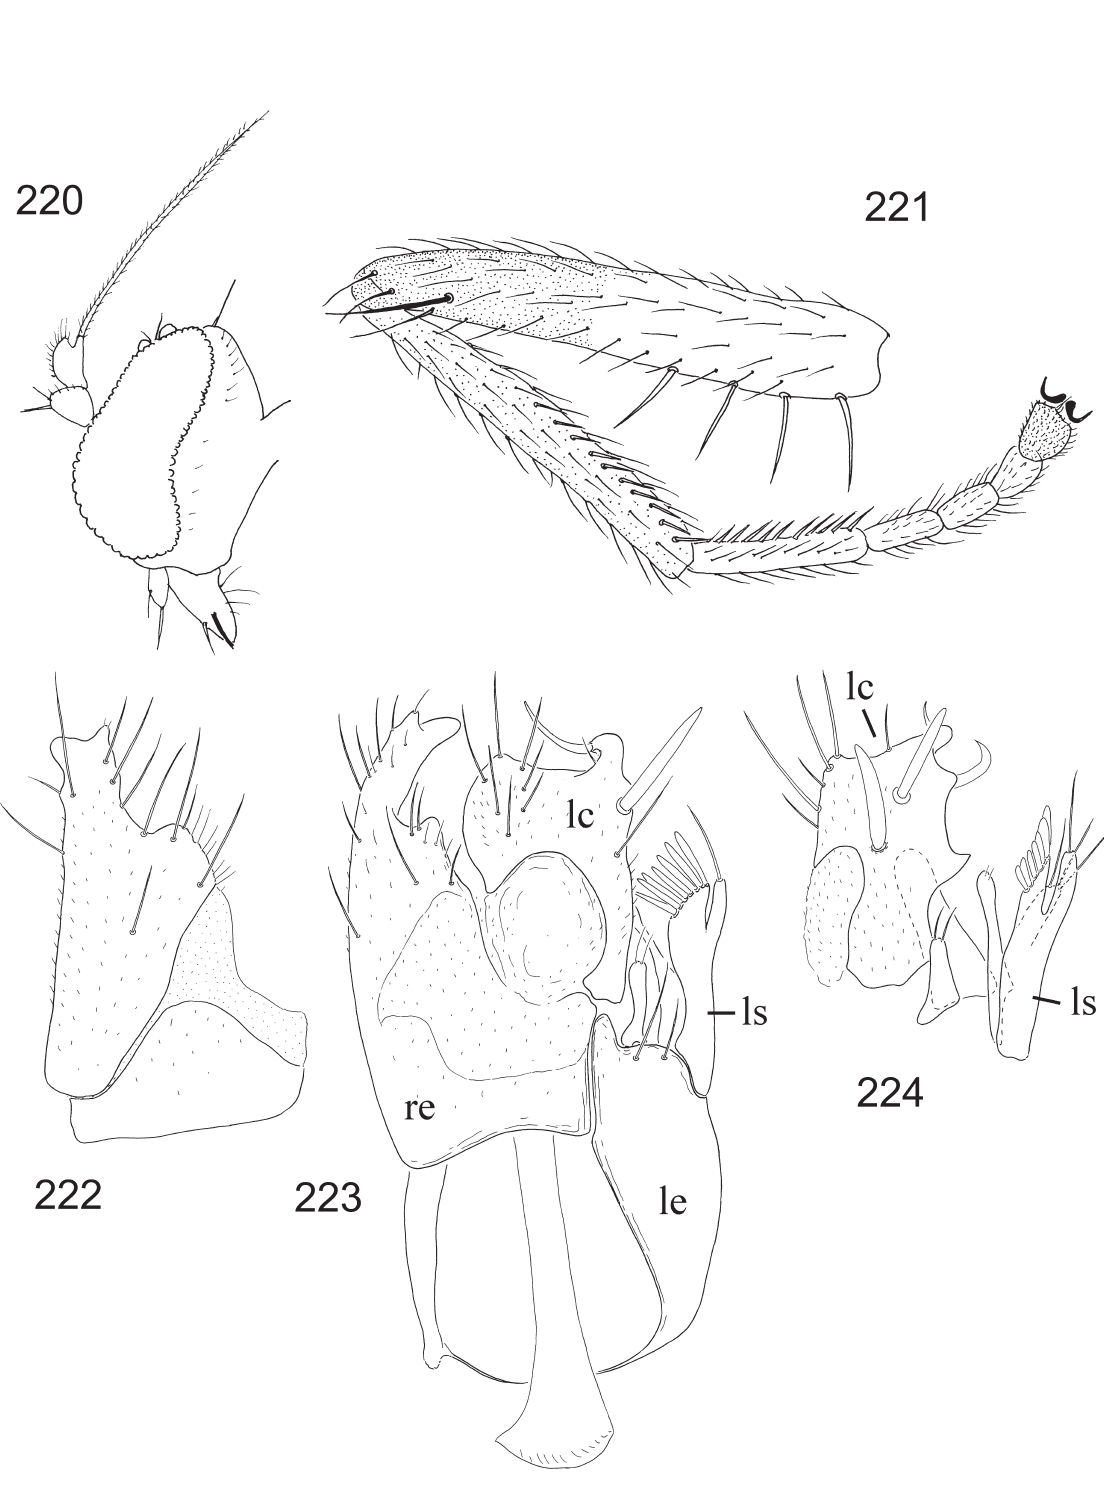
Figs 220-224. Stilpon neesoonensis sp. nov., ♂. 220 . head lateral, lateral view. 221 . mid leg, anterior view. 222 . right epandrial lamella, lateral view. 223 . epandrium with cerci, dorsal view. 224 . left surstylus and cercus, dorso-lateral